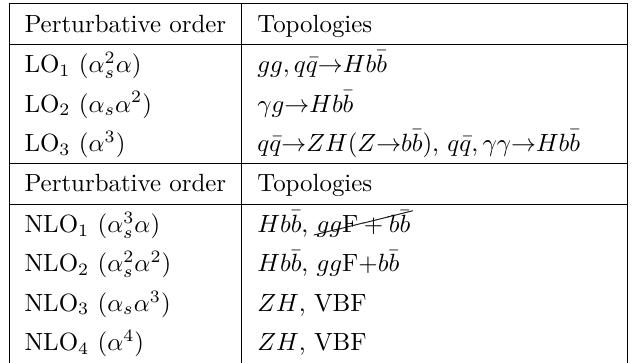
Table 1 . Topologies entering at LO, with initial states that are explicitly specified, and at NLO. As discussed in section 2.3, the terms proportional to y b y t in NLO 1 , emerging from the interference of Hb ¯ b and gg F+ b ¯ b topologies, are not taken into account in our